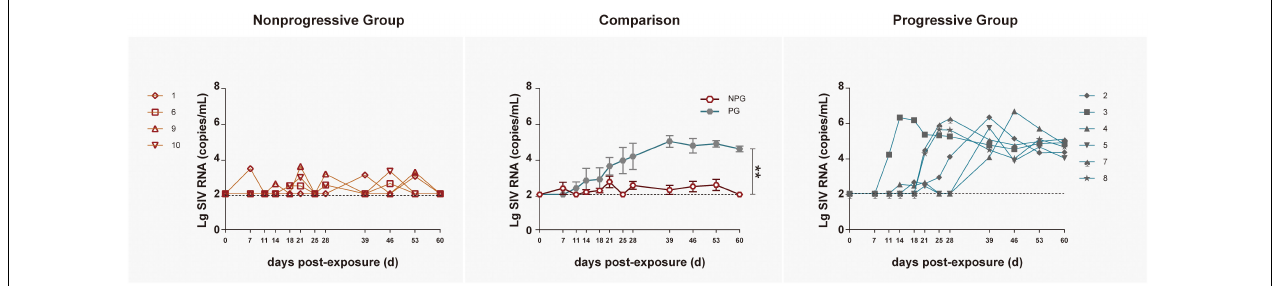
FIGURE 2 | Tracking plasma viral loads by detecting SIV RNA in non-progressive and progressive monkeys. The log of the geometric mean of the number of plasma SIVmac239 copies was compared between four non-progressive monkeys (orange line) and six progressive monkeys (blue line). The plasma viral loads are shown as log10 copies/ml. The assay had a sensitivity of 100 viral RNA copies per ml of plasma (black dotted lines). According to the Mann–Whitney U -test, the viral load in progressive monkeys was significantly increased compared with that in non-progressive monkeys (** P <